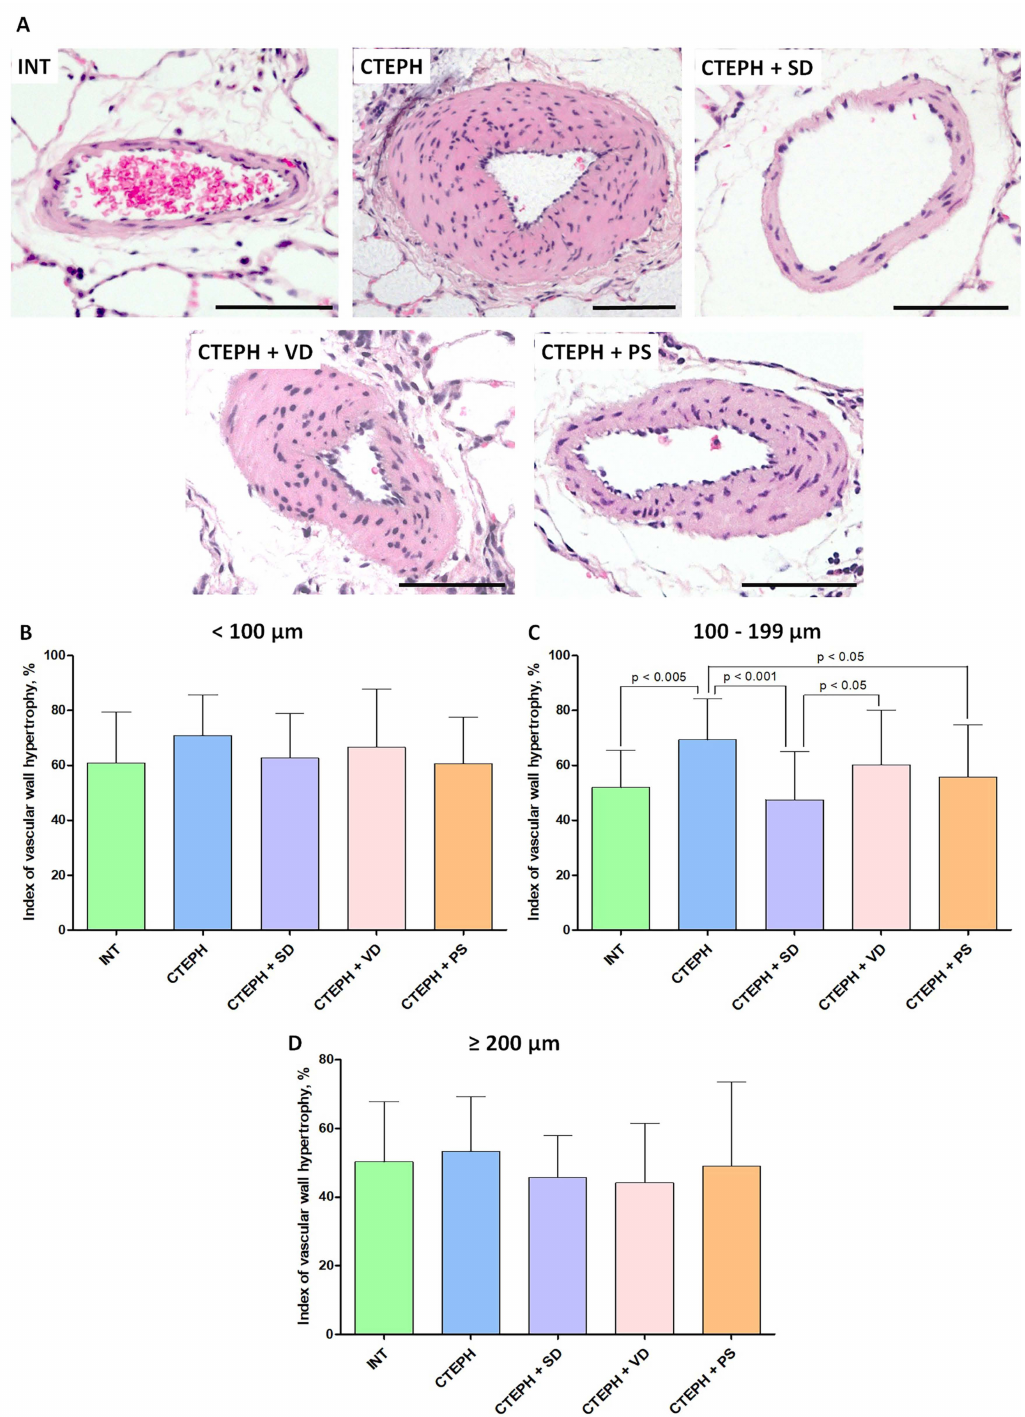
Figure 4. Histological examination of the lung vessels. ( A )—representative microphotographs of the branches of the pulmonary artery in studied groups, staining: hematoxylin–eosin, scale bar: 100 µ m. ( B – D )—Index of hypertrophy in pulmonary artery branches with different diameters at the end of 6-week follow up period after microspheres administration. ( B )—outer diameter of ves- sel < 100 µ m, ( C )—outer diameter of vessel 100–199 µ m, ( D )—outer diameter of vessel ≥ 200 µ m, INT—intact animals (n = 7), CTEPH—chronic thromboembolic pulmonary hypertension (n = 6), CTEPH + SD—CTEPH + sympathetic denervation (n = 6), CTEPH + VD—CTEPH + vagus denerva- tion (n = 6), CTEPH + PS—CTEPH + pyridostigmine (n =